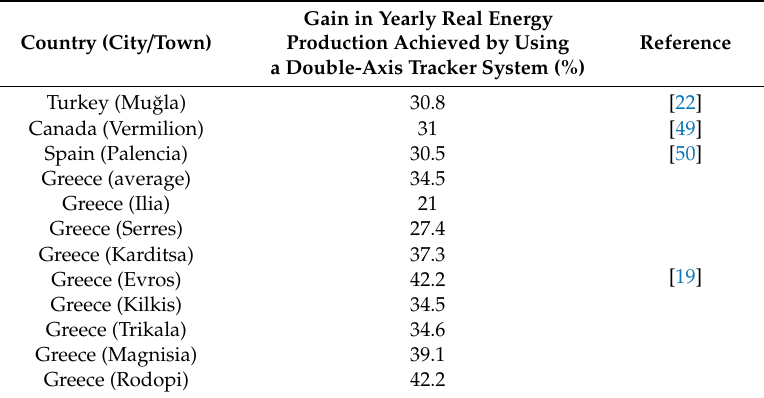
Table 1. The gain in yearly real energy production compared to optimally positioned south-facing crystalline photovoltaic (PV) systems.